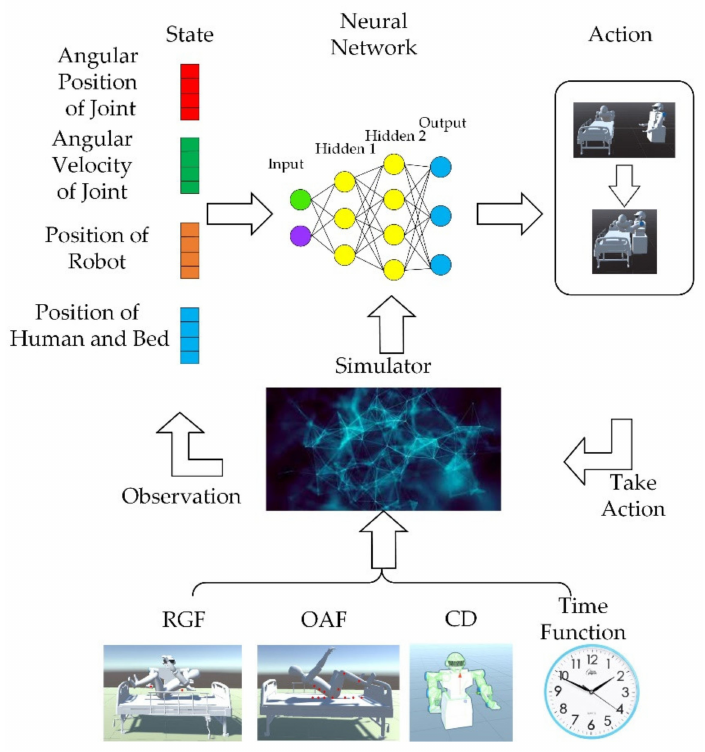
Figure 1. The graphical abstract of this article.